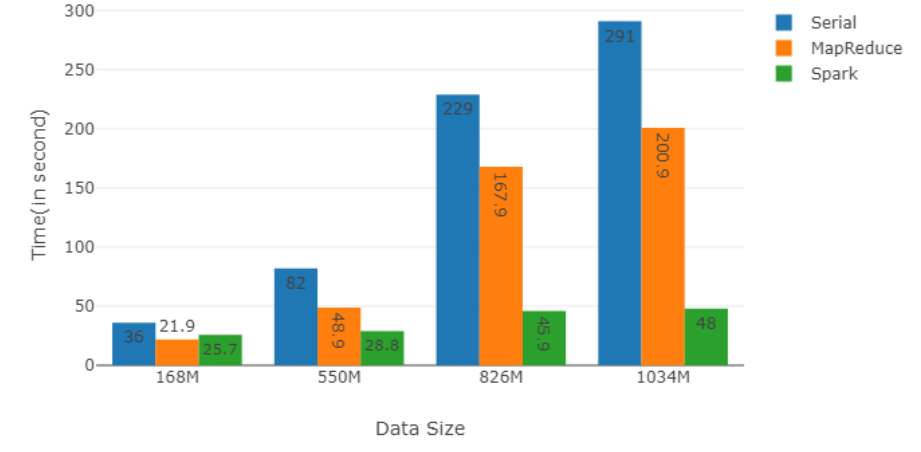
Figure 15. Computation performance of Spark, MapReduce and Serial programming.